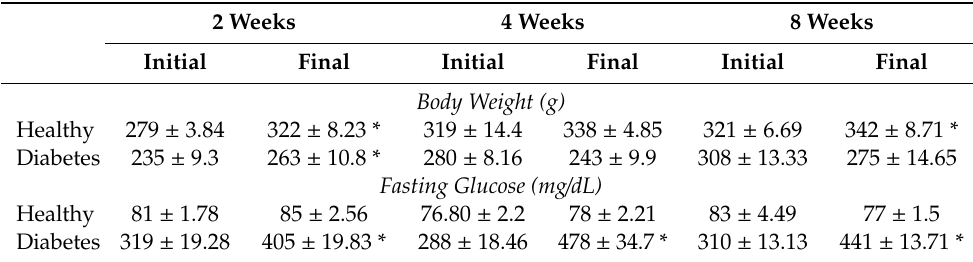
Table 1. Bodyweight and serum glucose levels in rats. 2 Weeks 4